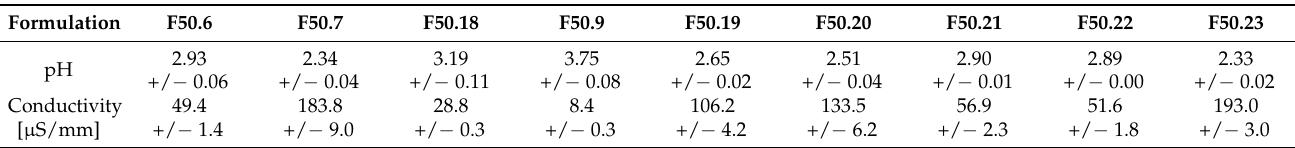
Table 11. Synergism of PCC/Mg(OH) 2 couple. The measures are performed according to EN 60754-2 at 950 ◦ C. The mean values and the SD are reported.